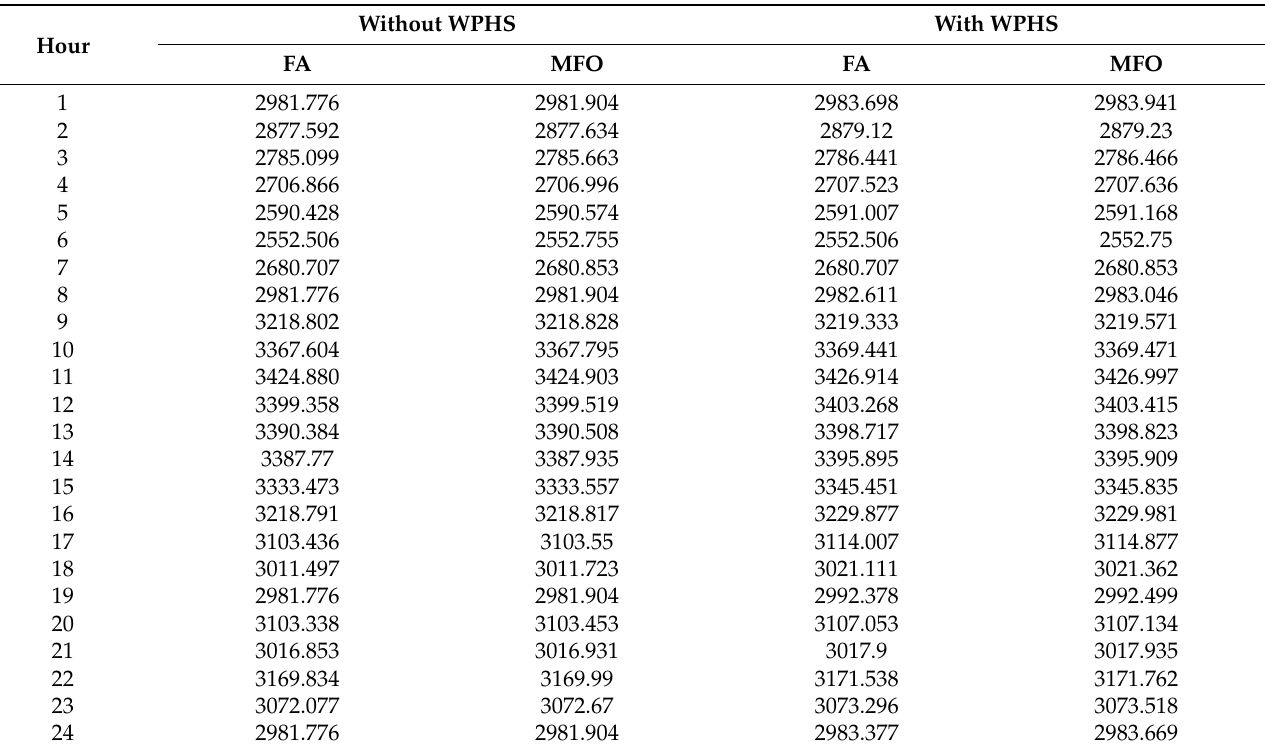
Table 3. Social welfare with and without WPHS for 24 h scheduling period.